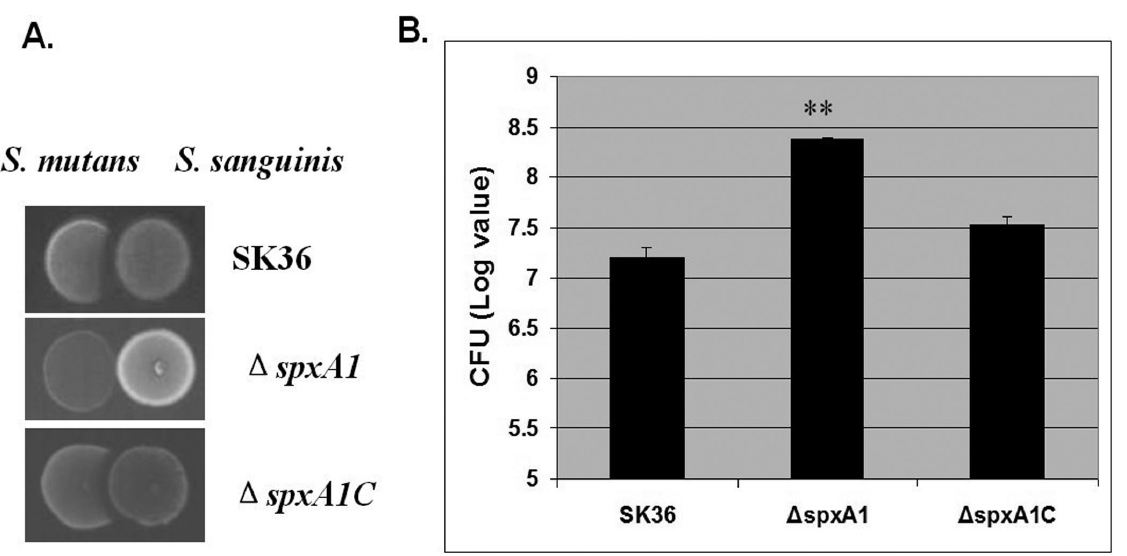
Figure 2. Inhibitory effect of S.sanguinis strains on S.mutans . (A) Inhibition assay on plates. Overnight cultures of S. sanguinis SK36, D spxA1 or D spxA1C wereinoculatedonBHIplates,whichwereincubatedfor16 hat37 u Cundermicroaerobicconditions. S.mutans UA159wastheninoculatednextto the pioneer colonizer, and the plates were further incubated overnight and photographed. (B) Inhibition assay in liquid media. Overnight cultures of S. sanguinis SK36, D spxA1 or D spxA1C wereadjustedtothesameopticaldensityandmixedwiththe S.mutanssmx_42 infreshBHImedium.Afterovernight growth, the cells were serially diluted and plated on BHI plates supplemented with chloramphenicol. The CFUs of S. mutans are indicated in logarithmic values, with standard deviations calculated from triplicate mixtures (** P , 0.01 relative to the values obtained for the SK36 mixture).